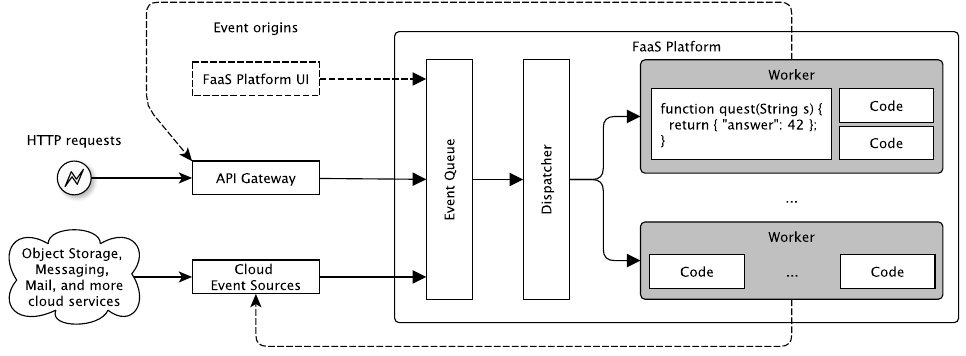
Figure 8. Serverless platform architecture, taken from